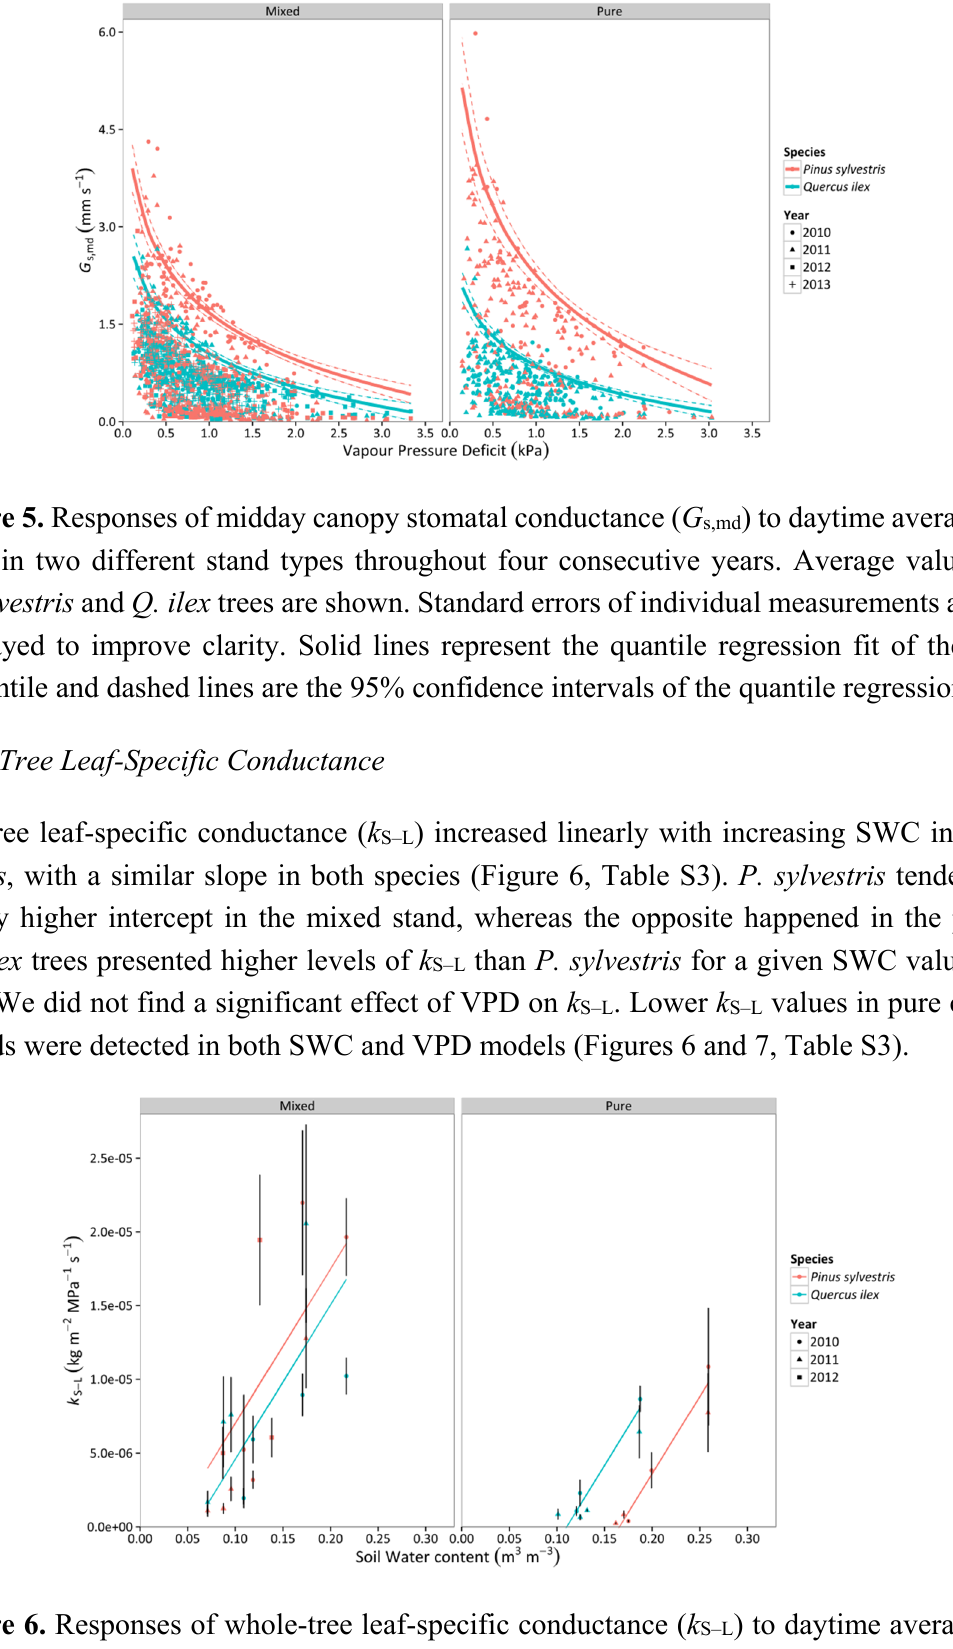
Figure 6. Responses of whole-tree leaf-specific conductance ( k S–L ) to daytime averages of SWC in two different stand types throughout three consecutive years. Average values for P. sylvestris and Q. ilex trees are shown. Error bars indicate ±1 SE. The regressions for